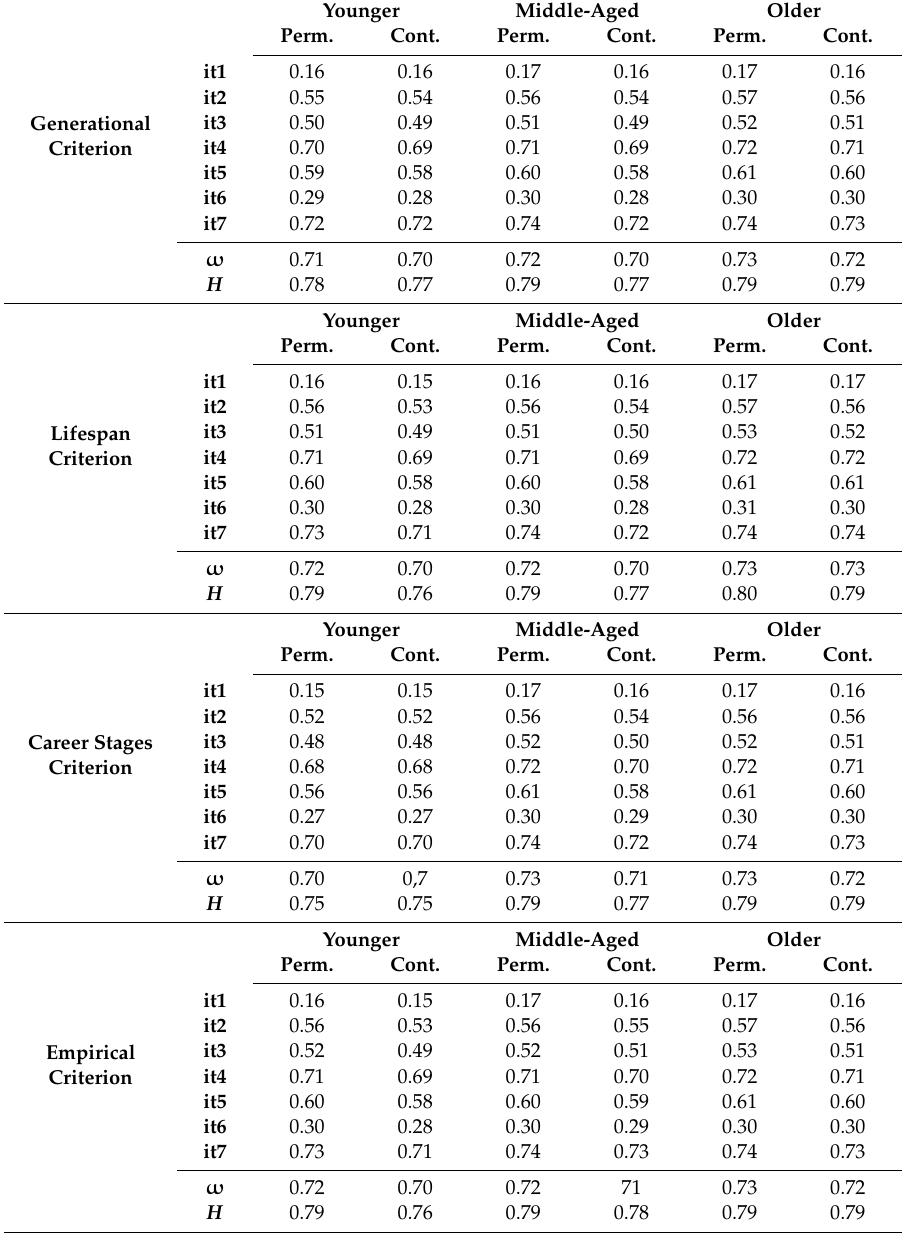
Table 5. Standardized factor loadings and reliability coe ffi cients from the final multi-group models. Younger Middle-Aged Older Perm. Cont. Perm. Cont. Perm.